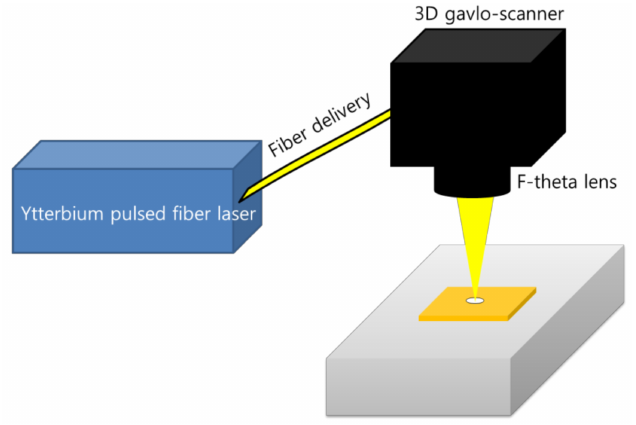
Figure 1. Experimental